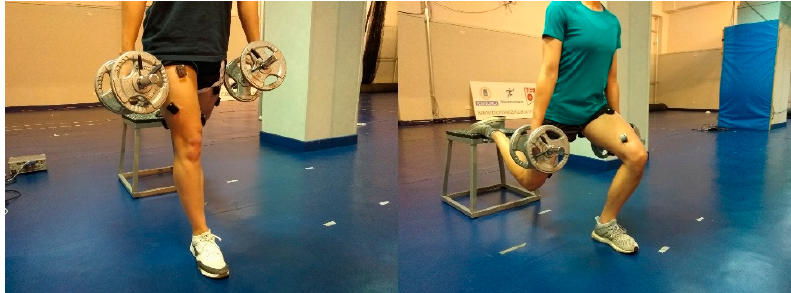
Figure 1. Starting position ( left ) and execution ( right ) of the Bulgarian squat exercise.